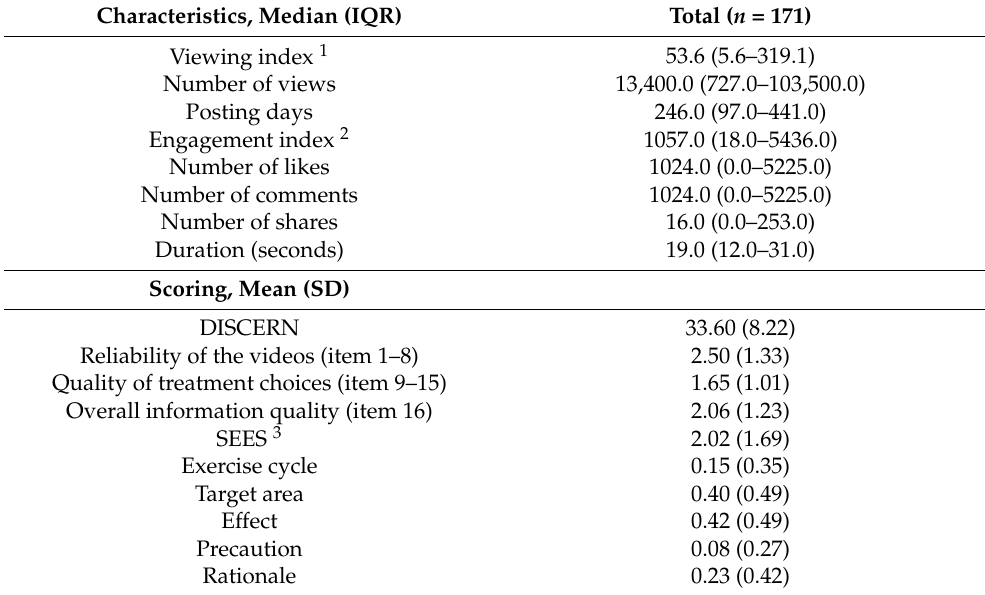
Table 1. Characteristics of included